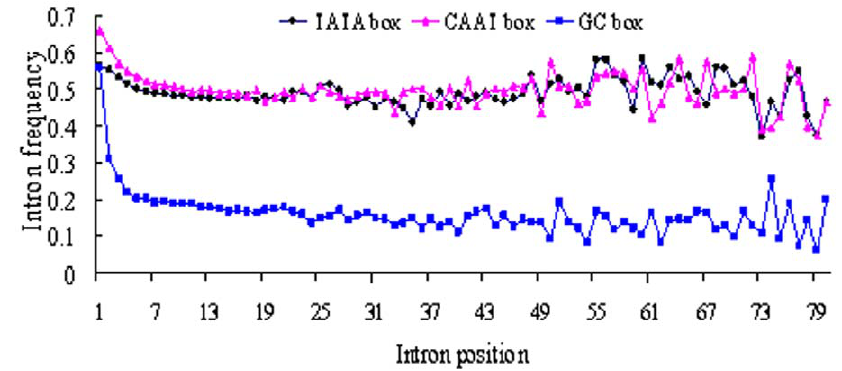
Figure 5. TATA, CAAT and GC boxes frequencies in introns